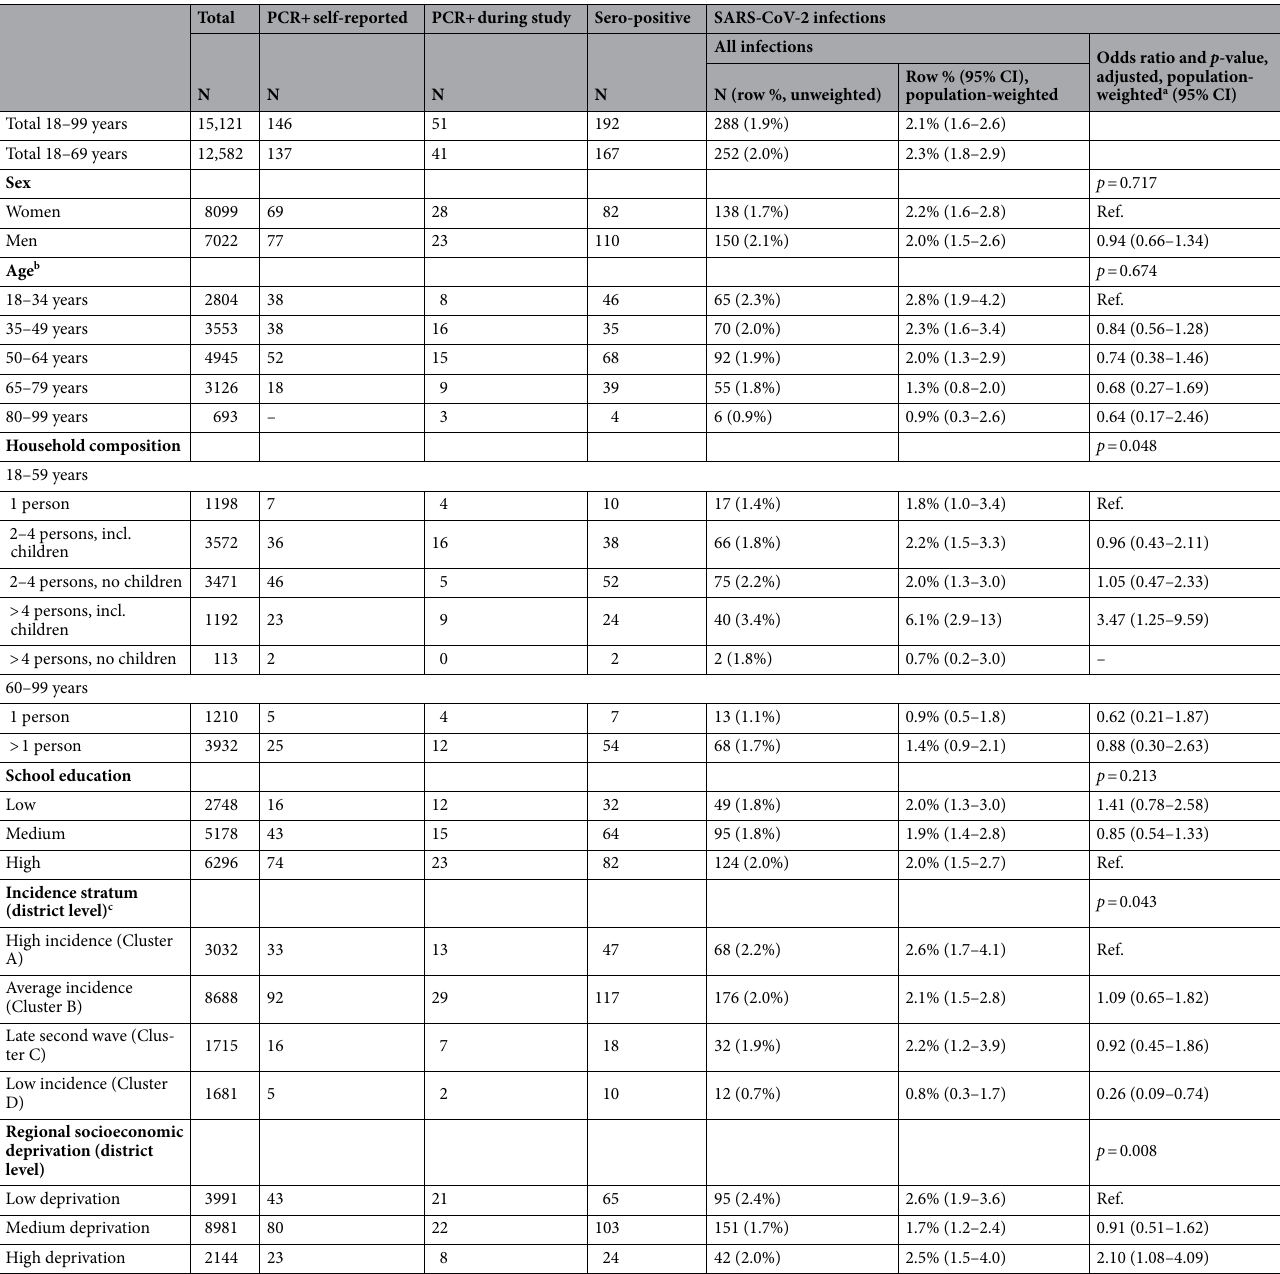
Table 1. Characteristics and SARS-CoV-2 infection status in community-dwelling adults in Germany (15,122 RKI-SOEP study participants, predominantly October–November 2020). Numbers do not add up to total due to missing values in single variables (available-case analysis). a Odds ratio mutually adjusted for the variables in this table (with age modelled as a natural cubic spline), date of study participation (as a linear variable) and sampling batch. p-value for the joint test of each variable within a survey logistic regression model. b The ORs for age are derived from the spline, using the mean age within each age group, i.e. 26 years (the reference), 43 years, 57 years, 71 years and 83 years. c District incidence strata according to pattern of weekly sequence of district SARS-CoV-2 incidence (notified cases), see Supplement